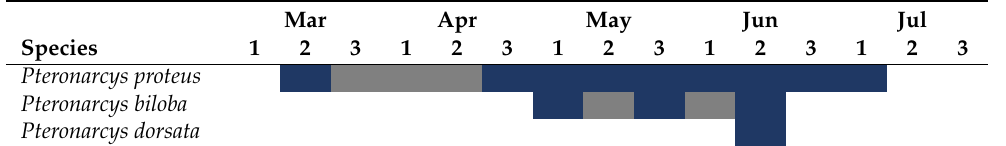
Figure 14. Elevation boxplots for Pteronarcyidae species recorded from Maryland. Boxes represent the interquartile range, while vertical lines extend to the minimum and maximum values. The horizontal line within the interquartile range represents the median elevation. Outliers are shown with large, solid circles. Small, individual points overlaid on each boxplot illustrate the distribution of observations. Table 11. Recorded adult Pteronarcyidae presence in Maryland. Months are broken into three 10-day periods. Dark blue squares represent periods with collections. Gray squares represent periods when species may be